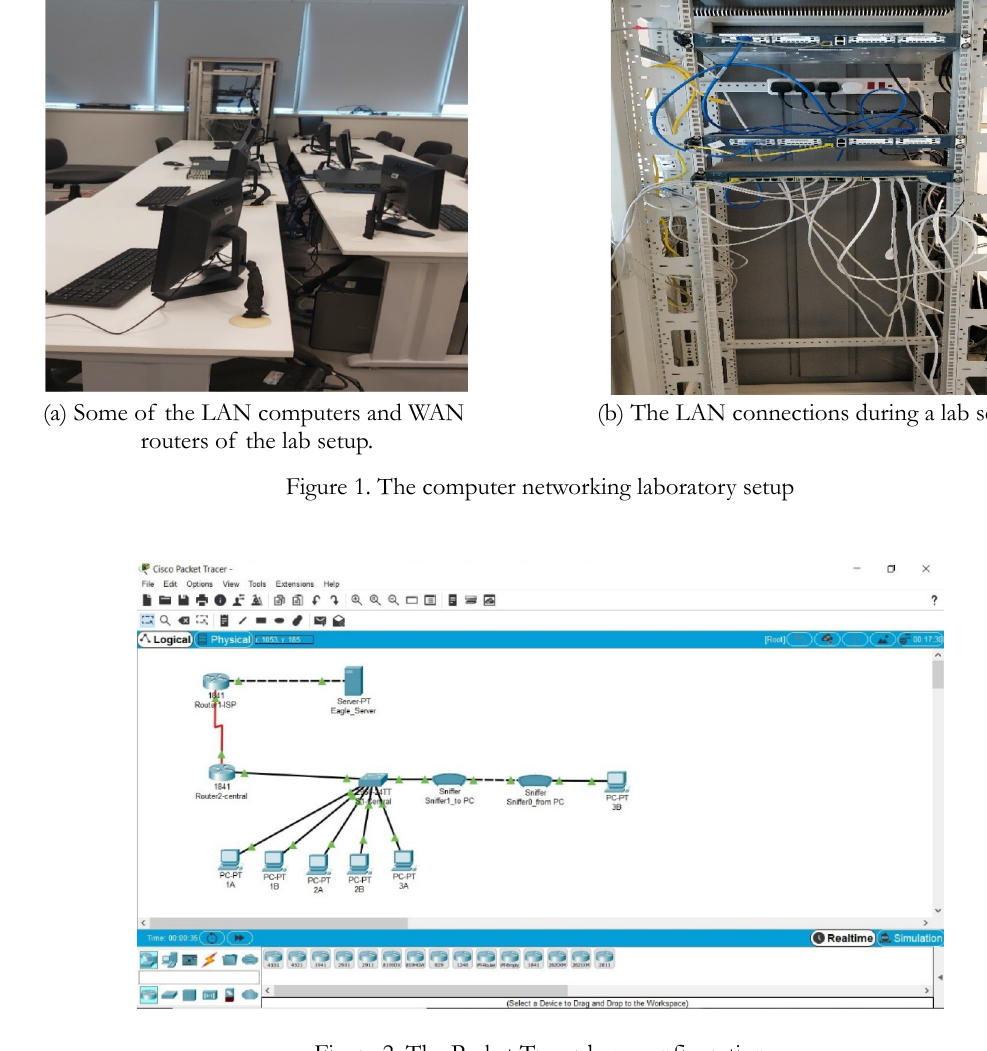
Figure 2. The Packet Tracer base